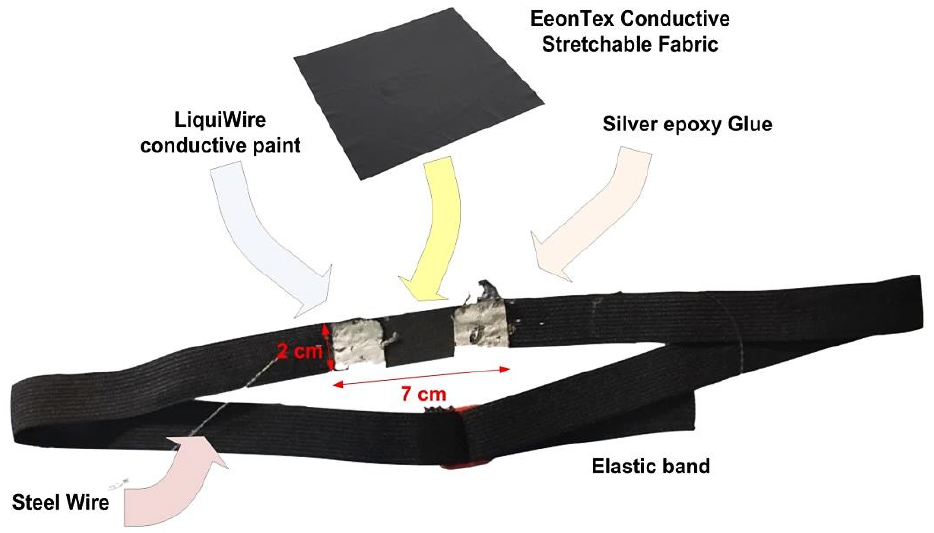
Figure 1. Structure of the developed piezoresistive band for RR detection.